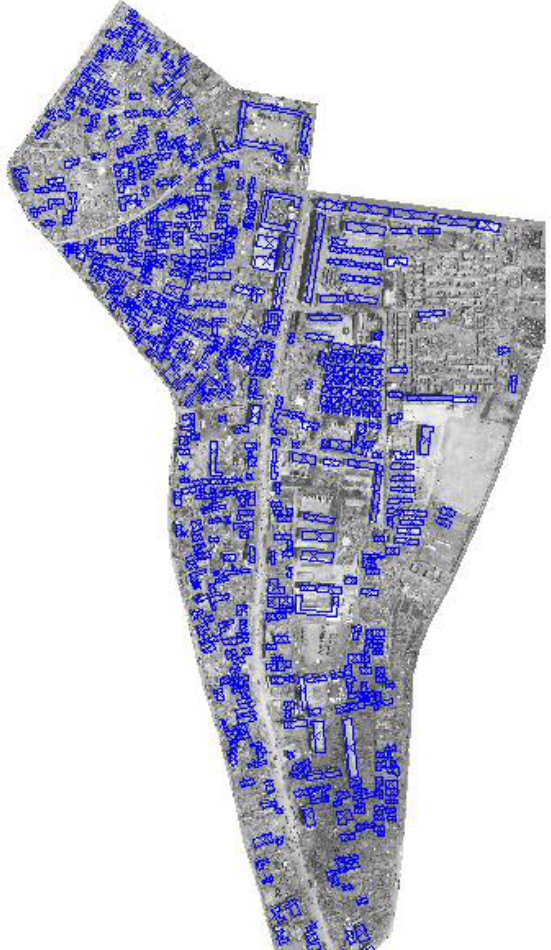
Figure 1. Test data set. Post-event image overlaid with building layer from the vector map. Satellite image courtesy of Digital Globe (©Digital Globe 2010).